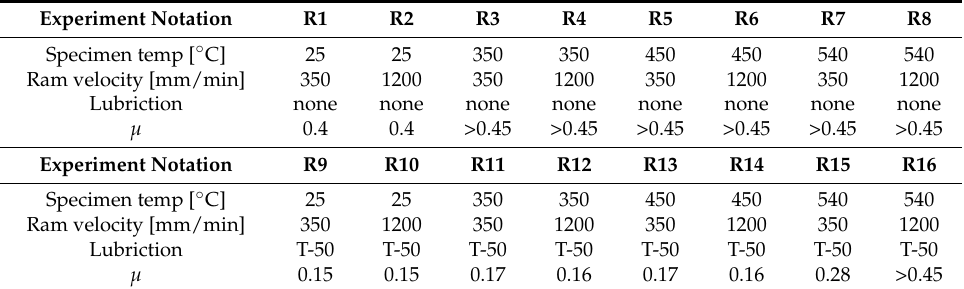
Table 4. Friction coefficients obtained from analysis of the upsetting experiments.